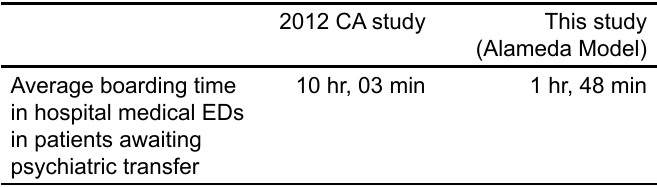
Table 4. Comparison of average boarding times, Alameda model versus 2012 California (CA)